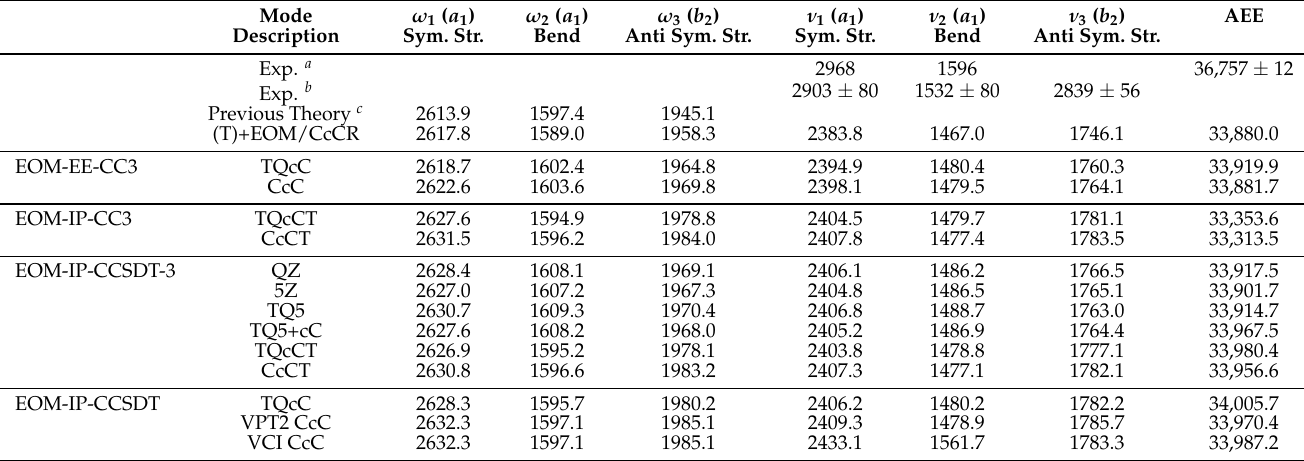
Table 7. ˜B 2 B 2 H 2 O + Vibrational Frequencies in cm − 1